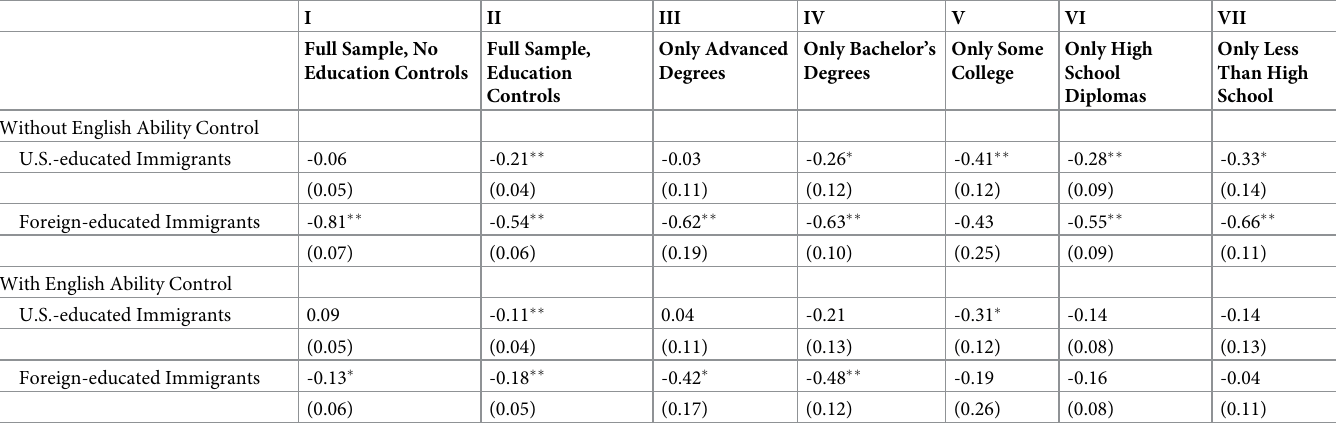
Table 4. Immigrant-native differences in PIAAC numeracy